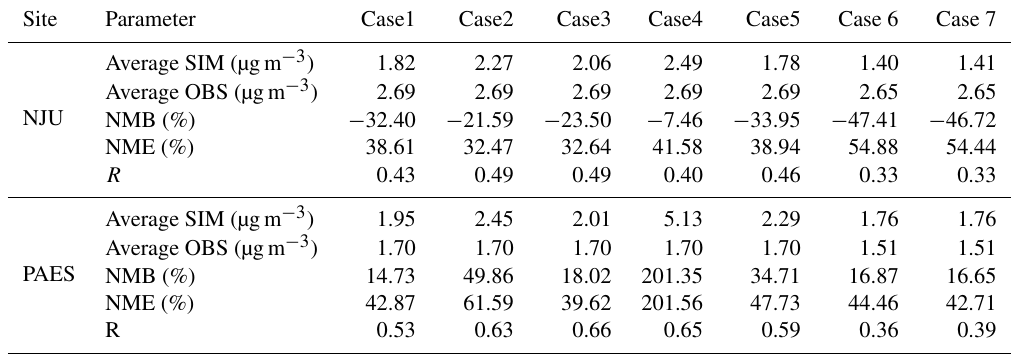
Table 3. Statistical indicators for observed and simulated BC concentrations in different cases at NJU and PAES (Cases 1–5 for April and Cases 6–7 for July).